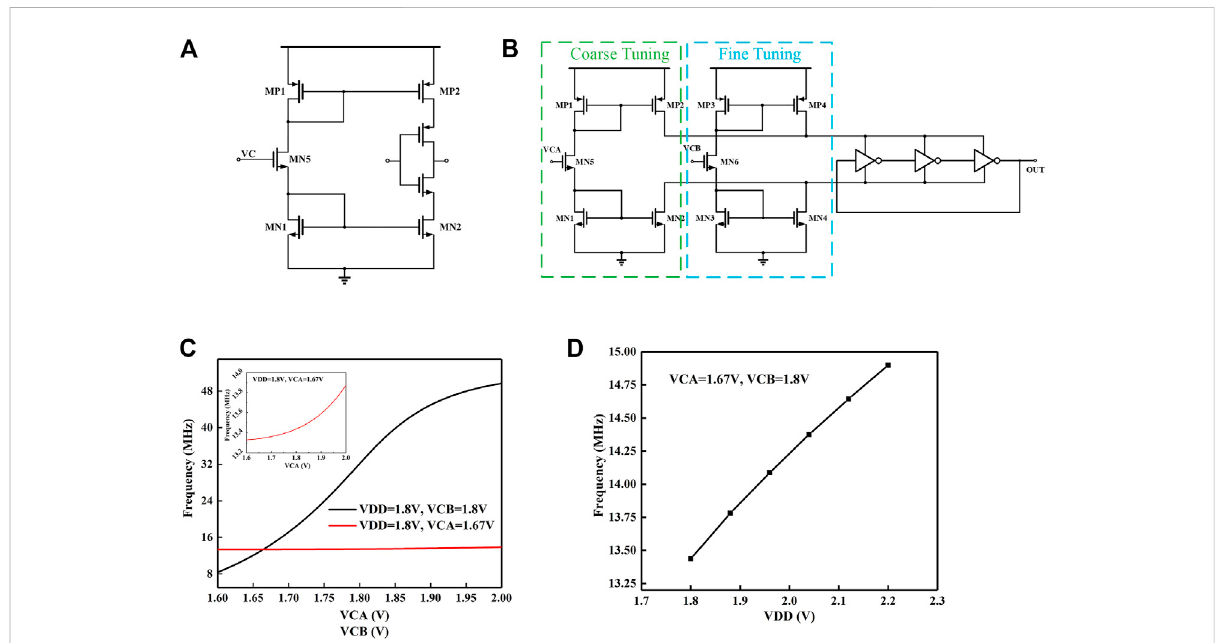
FIGURE 3 Low-power wireless information-sending unit. (A) Schematic of the current-starved delay element; (B) schematic of the low-power current- starved ring oscillator, and the circuit has coarse- and fi ne-tuning functions to achieve frequency alignment and threshold judgment, respectively; (C) simulation of the variation curve of oscillation frequency with VCA and VCB; and (D) simulation of the variation curve of oscillation frequency with